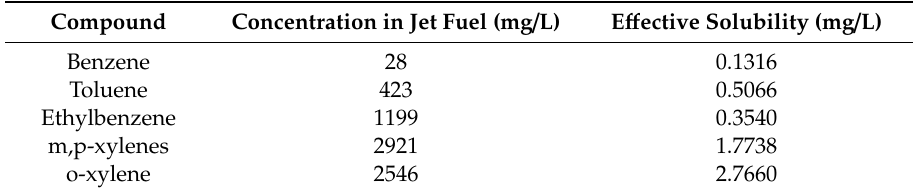
Table 1. Benzene, toluene, ethylbenzene, and xylenes (BTEX) compounds in jet fuel and their effective solubility, according to Raoult’s Law.